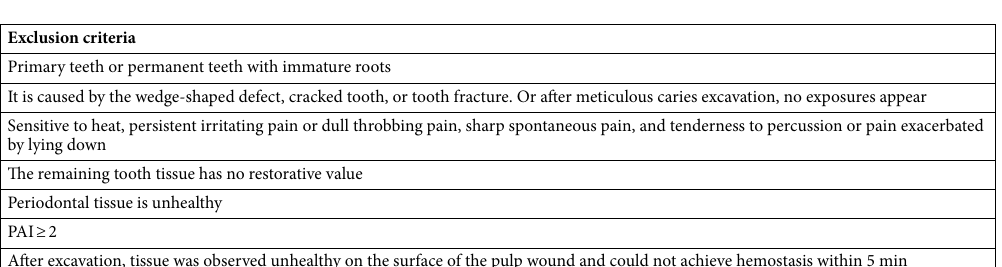
Table 2. Exclusion